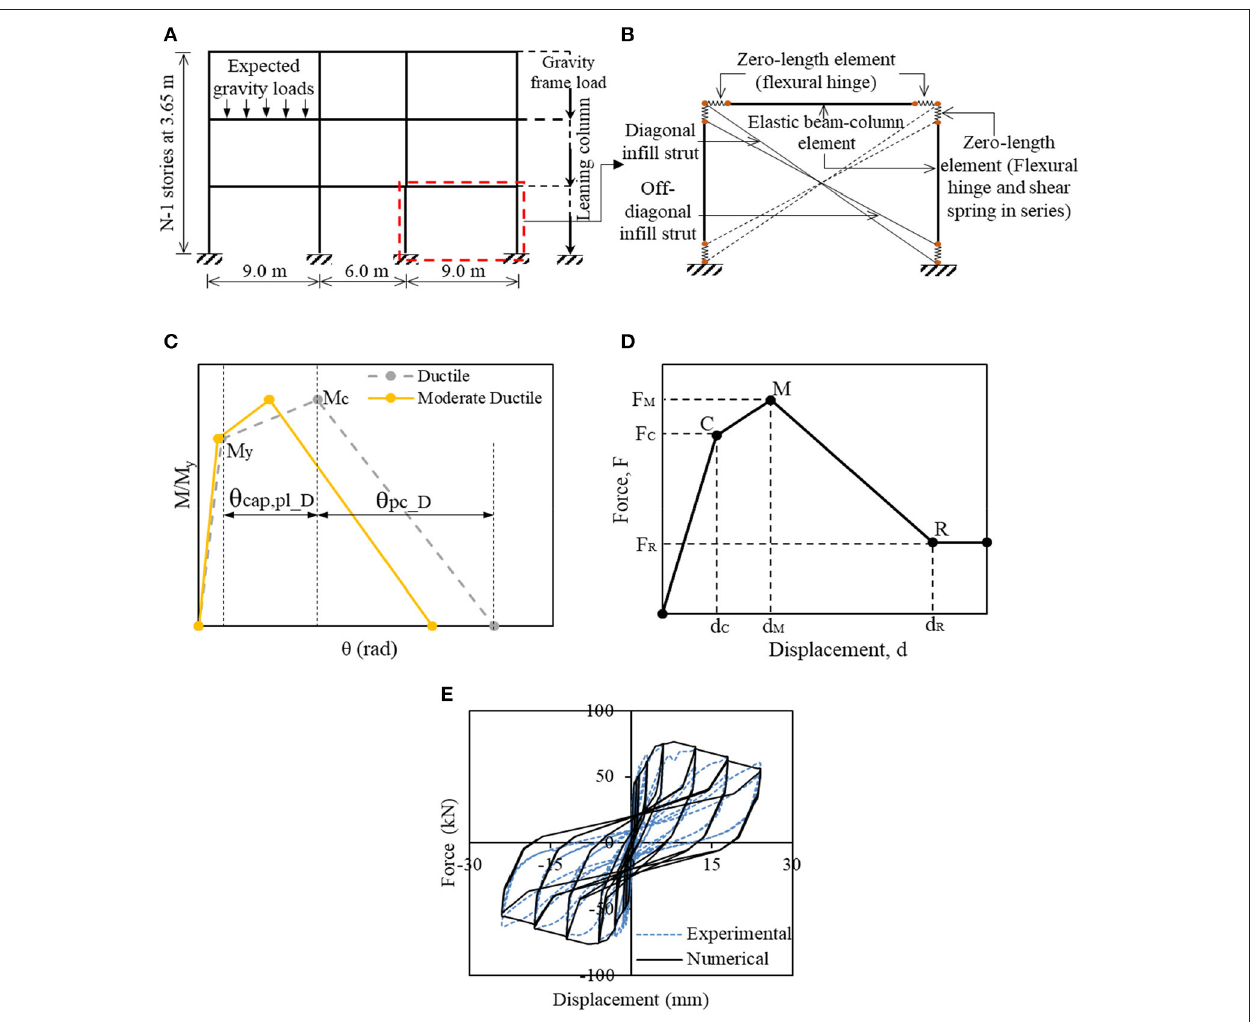
FIGURE 3 | Schematic of RC frame modeling using lumped plasticity elements; (A) overview of overall model, (B) detail model for infilled—RC frame, (C) monotonic curve for RC frame member developed by Ibarra et al. (2005), (D) in-plane lateral force-displacement envelope model proposed by Decanini et al. (2014), and (E) hysteretic curve (cyclic